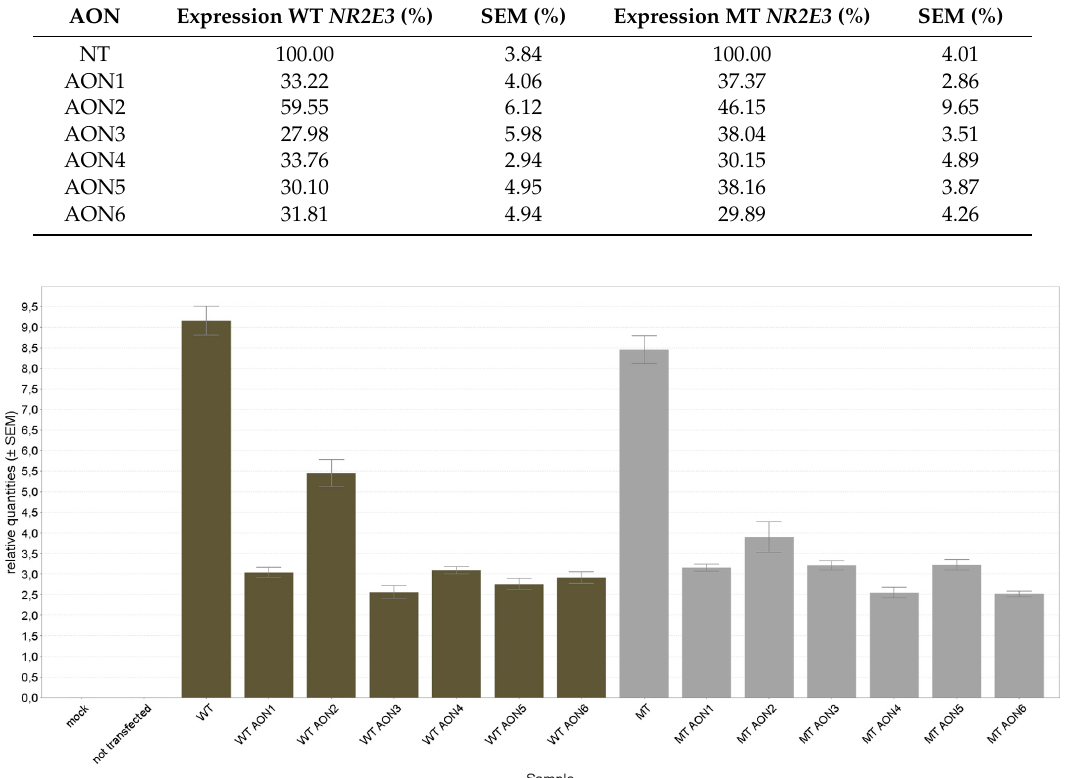
Figure 2. Quantitative polymerase chain reaction ( qPCR)-based expression analysis of messenger RNA (mRNA) from wild type (WT) or mutant (MT) NR2E3 overexpressed in RPE-1 cells and subsequently treated with AON1–6. All AONs lead to a partial knockdown of WT or MT NR2E3 mRNA expression. Error bars represent the standard error of the relative quantities. Mock transfected cells were transfected with an empty vector and show no NR2E3 expression.